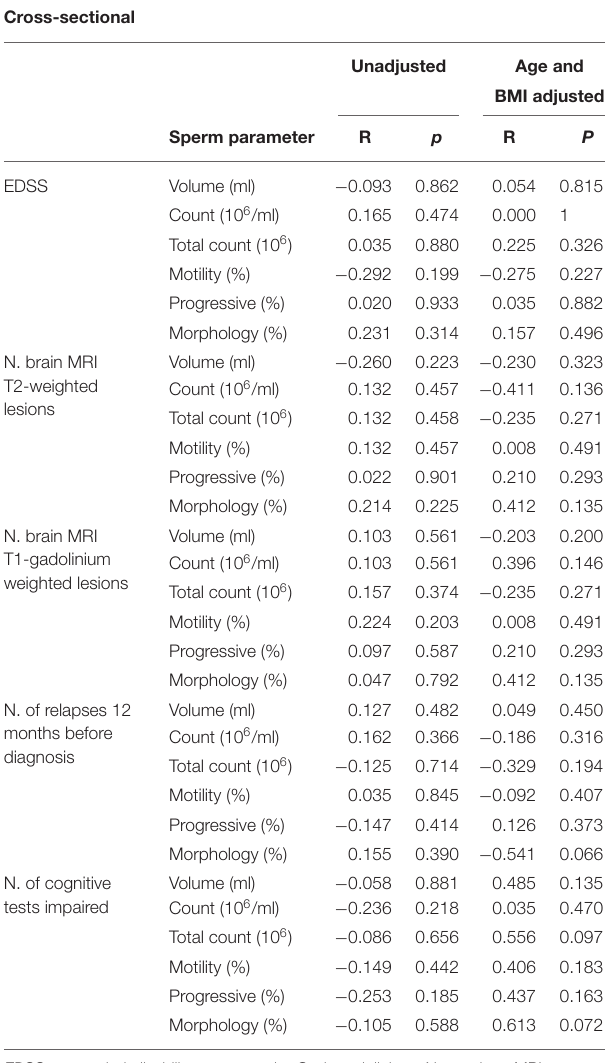
TABLE 3B | Association between baseline sperm parameters and baseline clinical (EDSS. number of relapses 12 months before diagnosis), baseline radiological (N. MRI T2 and T1-gadolium weighted lesions) and cognitive (number of impaired tests) cross-sectional